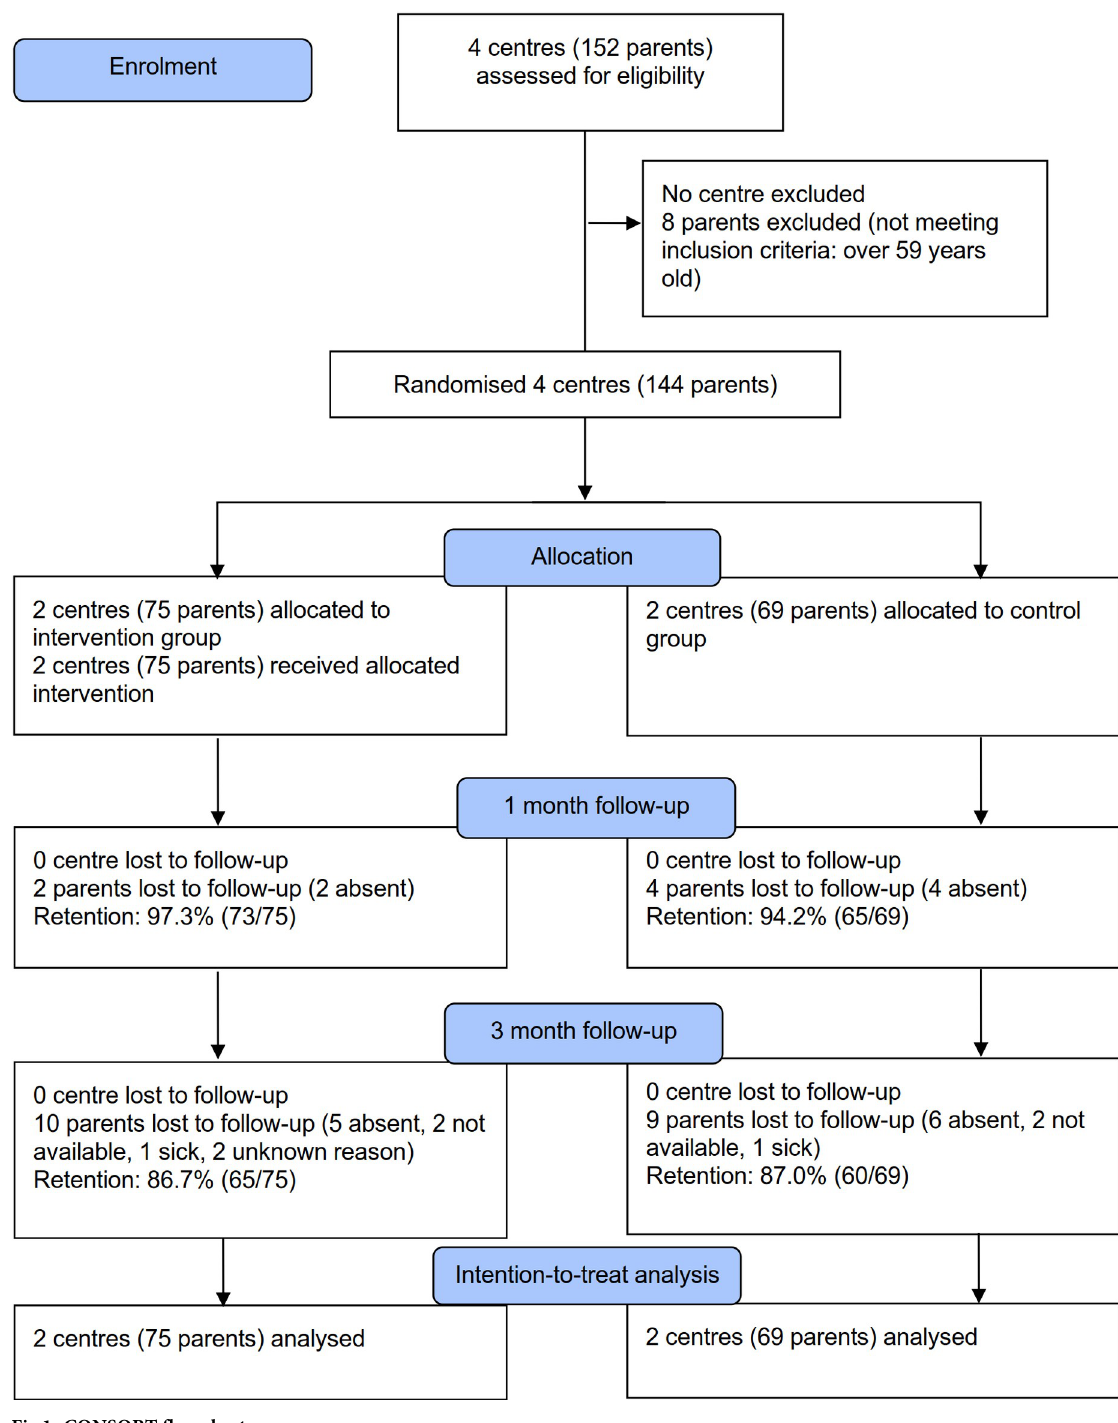
Fig 1. CONSORT flow